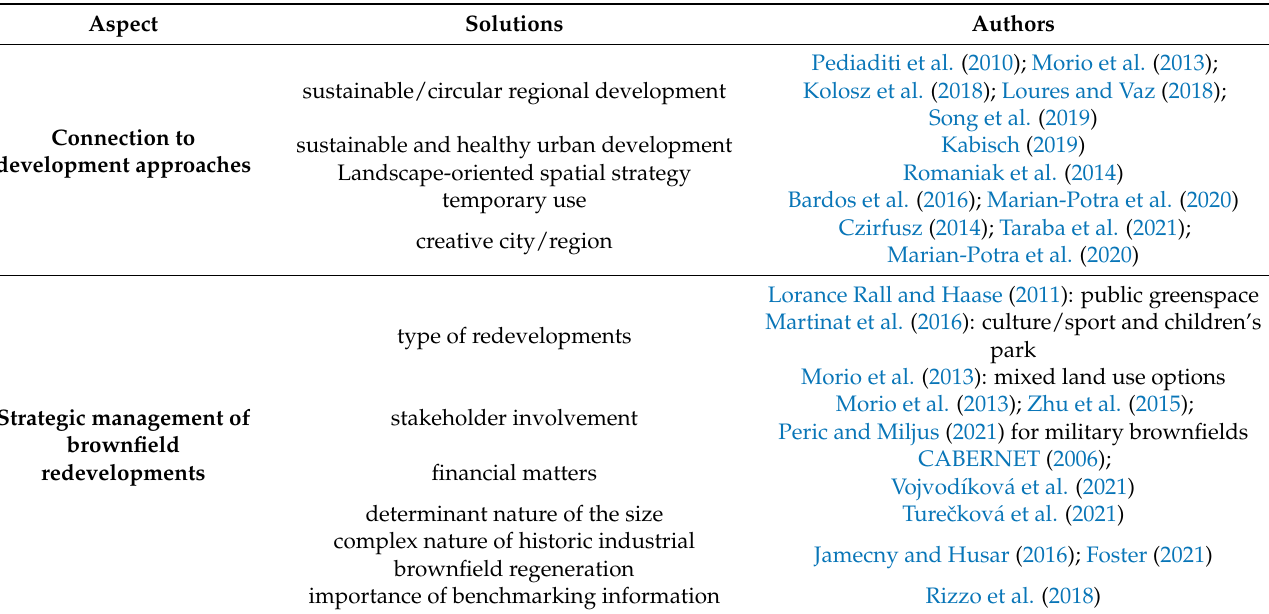
Table 1. Aspects for the redevelopment of